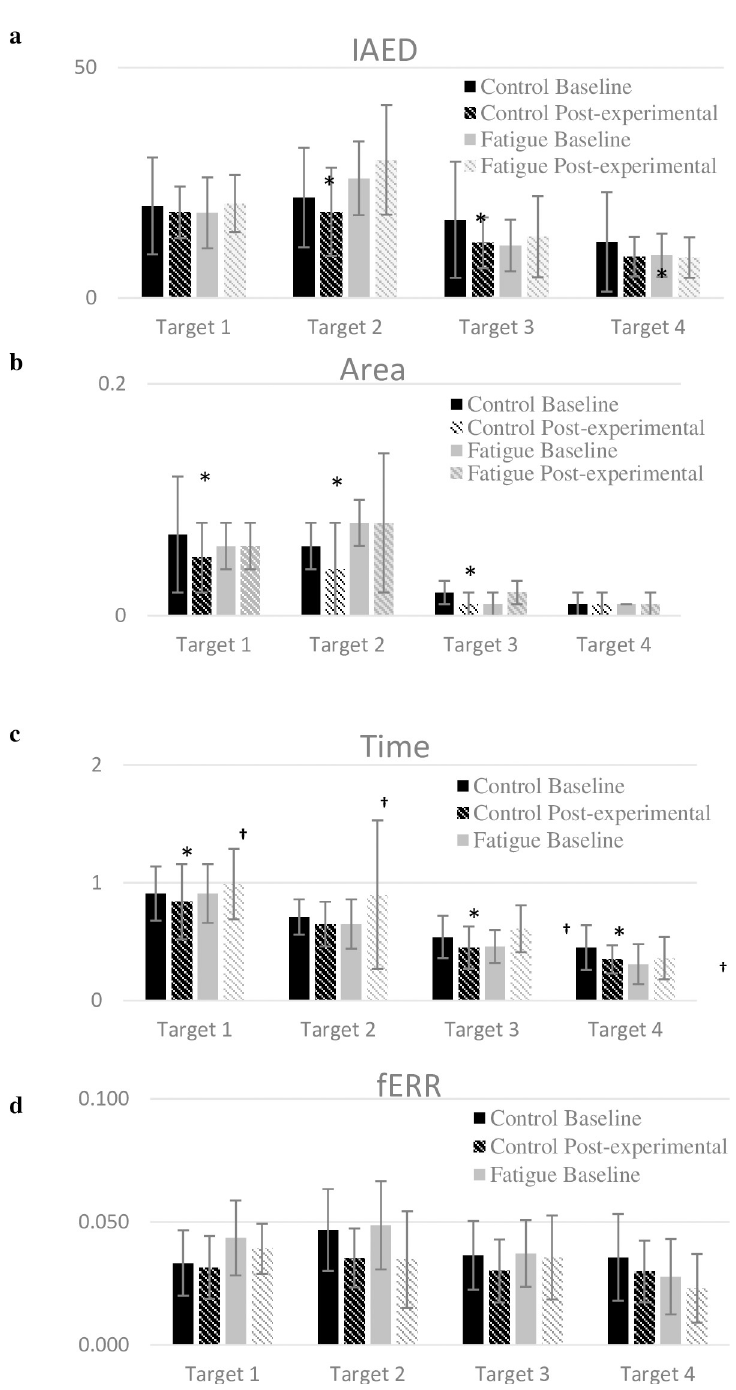
Fig 4. Spatiotemporal data during baseline and post-experimental condition of both groups. Data are presented as mean ± SD of Baseline and Experimental condition for both groups. a: iANG, initial angle of endpoint deviation (˚); b: Area, area under the curve (m 2 ); c: Time, time taken to reach the targets (s); d: fERR, final error, arc sign (m). Significant Time effect and Time x Group effect, p < 0.05, for iANG, Time and Area. No significant difference for fERR (Time effect: p = 0.226; and Time x Group effect: p = 0,33). � Significant increase of performance for controls compared to baseline, p < 0.05. † Significant decrease of performance compared to baseline, p < 0.05.